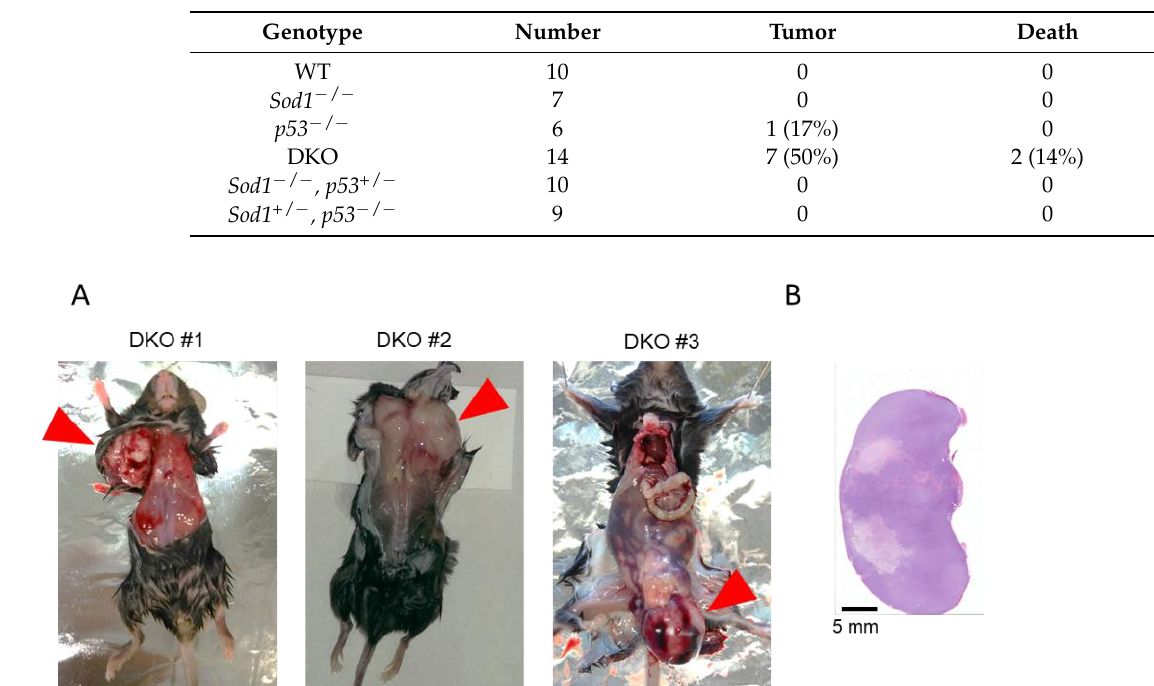
Figure 2. p53 loss had no marked effect on SOD1-decifient phenotypes in mice. ( A ) The body weight of each mouse (at four months of age). The genotypes for each mouse were as follows: (1) Wild-type ( n = 10); (2) Sod1 − / − ( n = 7); (3) p53 − / − ( n = 5); (4) Sod1 − / − , p53 − / − (DKO, n = 5); (5) Sod1 − / − , p53 + / − ( n = 10); (6) Sod1 + / − , p53 − / − ( n = 9). ( B ) The ratio of muscle weight corrected by body weight. ( C ) The ratio of liver weight corrected by body weight. ( D ) Hematoxylin and eosin staining, the thickness of the back skin, and the skin thickness of each mouse. ( E ) The ratio of the spleen weight corrected by the body weight. ( F ) The number of red blood cells in each mouse. Statistical analyses were performed using a two-way analysis of variance. The error bars indicate the standard deviation. * p < 0.05. ** p < 0.01 vs. WT. # p < 0.05 vs. Sod1 − / − . The scale bar represents 100 μm. Table 2. The number of tumor or death to each mouse until 4 months of age.